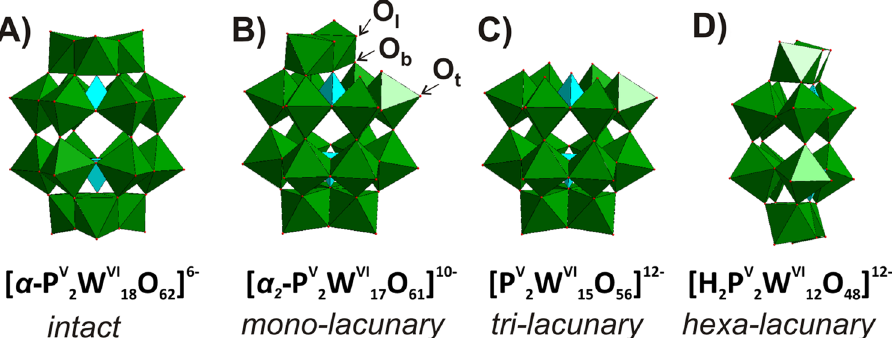
Figure 1. The POTs ( A – D ) feature the Wells–Dawson archetype and they are derived from the α -isomer of [P